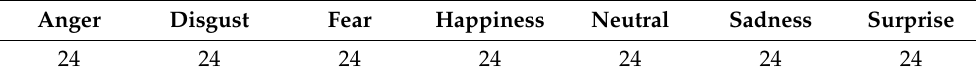
Table 3. Numbers of emotion samples used for the HMMs in the testing